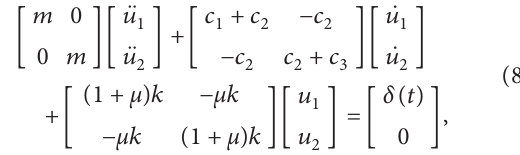
Figure 7: Scatter plots of initial center frequencies ω 1 constraint parameter (a) α � 1e3, (b) α � 1e4, and (c) α � 1e5, where the Hurst exponent H �